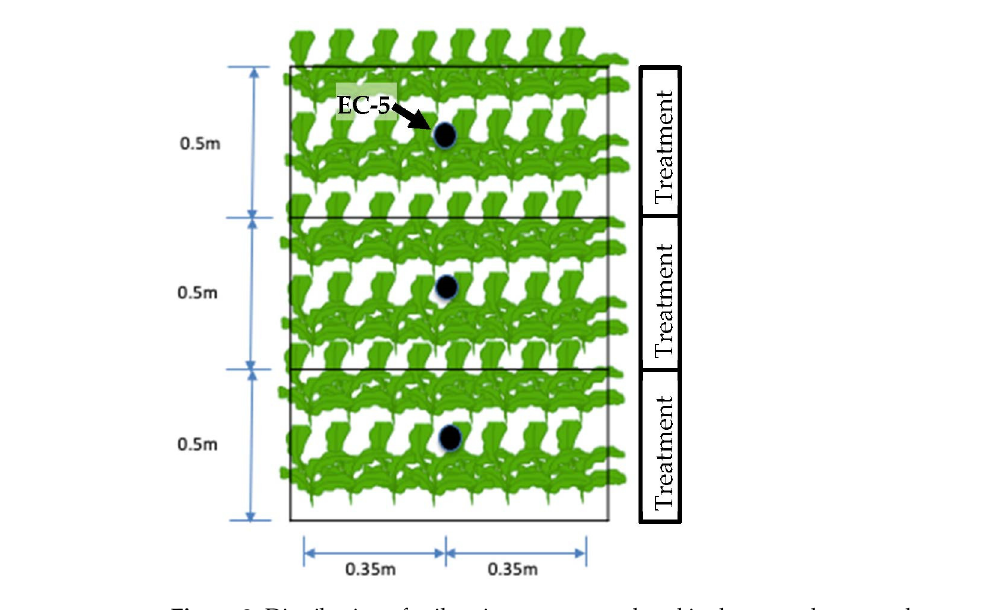
Figure 3. Distribution of soil moisture sensors placed in the center between the rows of each treatment in the experimental area.